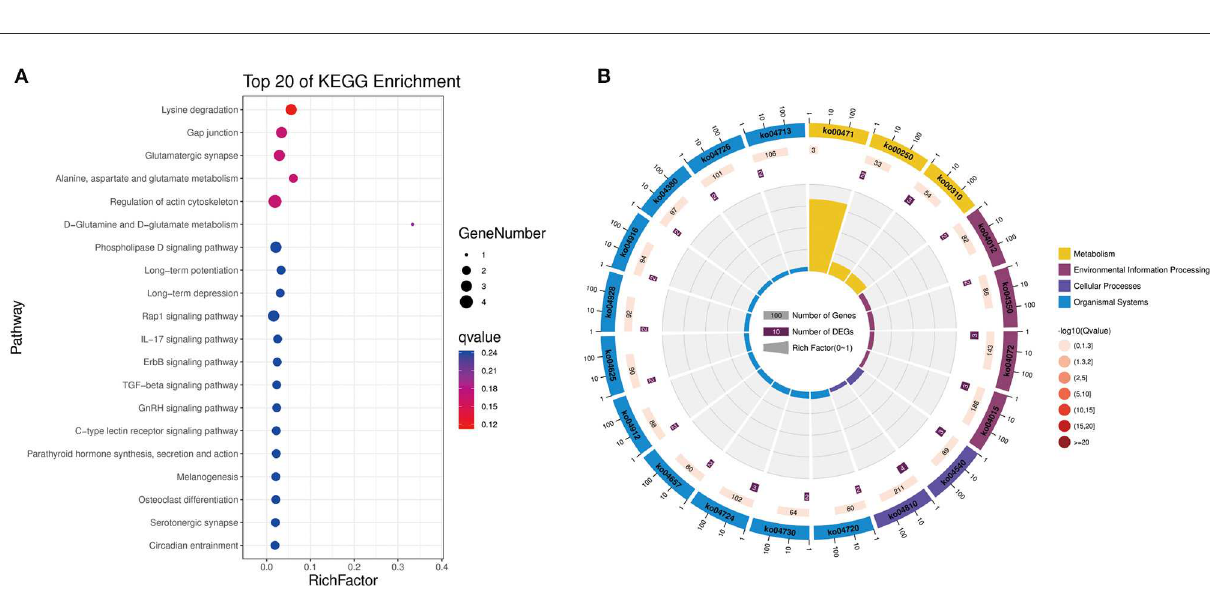
FrontiersinVeterinaryScience